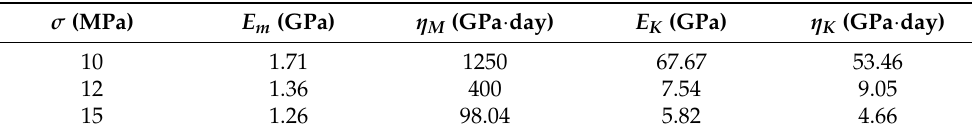
Table 7. Creep parameters of salt rocks. (Data are taken from Mansouri and Ajalloeian [152], Copyright©2022, with permission from the publisher, License No. 5361920269706).